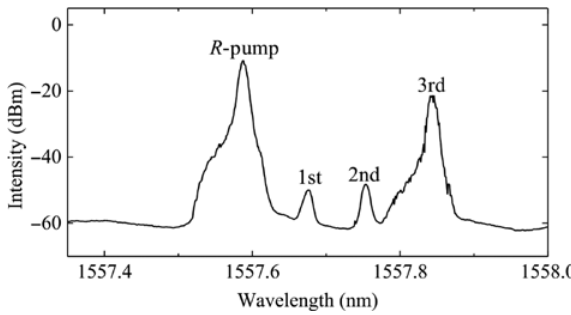
Figure 5: Cascaded Brillouin lasing spectrum in the backward direction.